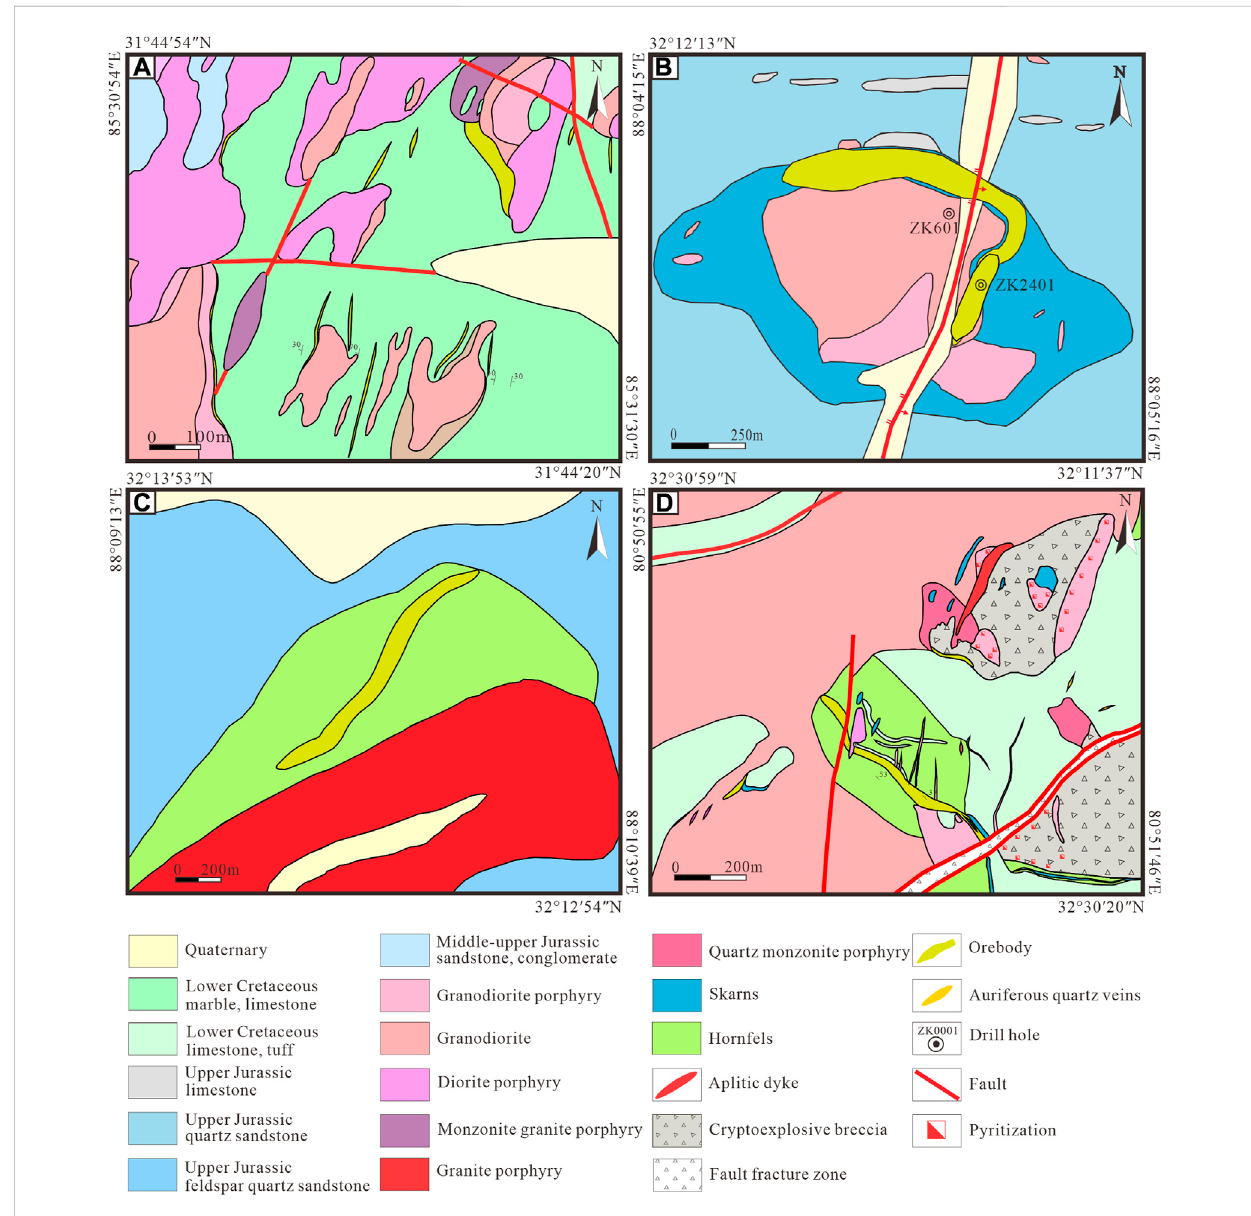
FIGURE 6 Geology of skarn deposits. (A) Balazha deposit (modi fi ed from Wang et al., 2013), (B) Daruoluolong deposit (modi fi ed from Wang et al., 2019d), (C) Gaobaojiayue deposit (modi fi ed from No. 5 Geological Party, Tibet Bureau of Geology and Exploration of Mineral Resources, 2014), and (D) Ga ’ erqiong deposit (modi fi ed from Tibet Institute of Geological Survey,